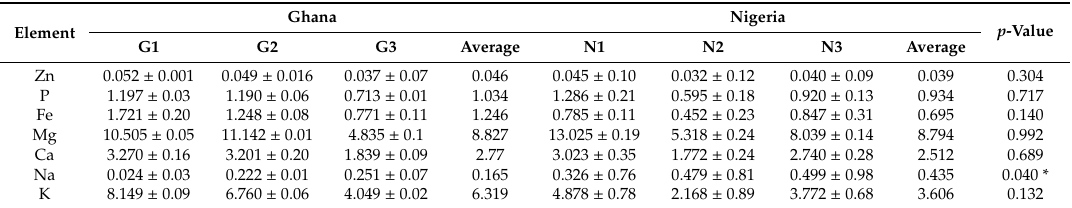
Table 2. Content of Zn, P, Fe, Mg, Ca, Na, and K (mg/g) in representative batches of X. aethiopica from Ghana and Nigeria.